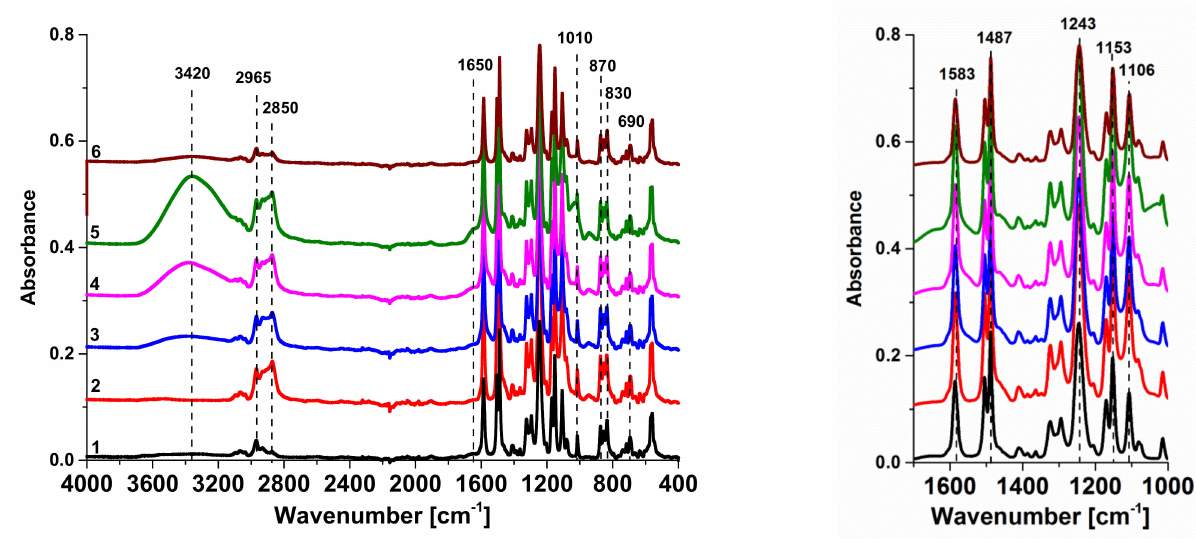
Figure 1. FTIR spectra of the selective layers (1–5) and a bottom layer (6) of PSF, PSF/Synperonic F108, and PSF/Synperonic F108/PAA membranes: 1—PSF-0; 2—SA-0; 3—SA-0.35; 4—SA-1.0; 5, 6—SA-1.5. The peaks at 1153, 1583, 1487, 1106, 1243, 2850, and 2965 cm − 1 correspond to PSF